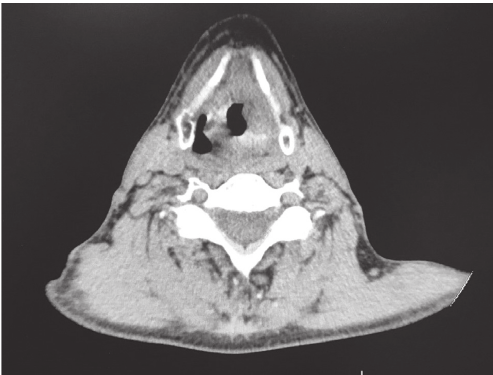
Figure 1: CT scan (axial view): an infiltrative mass at the left supraglottic area with extension to the left